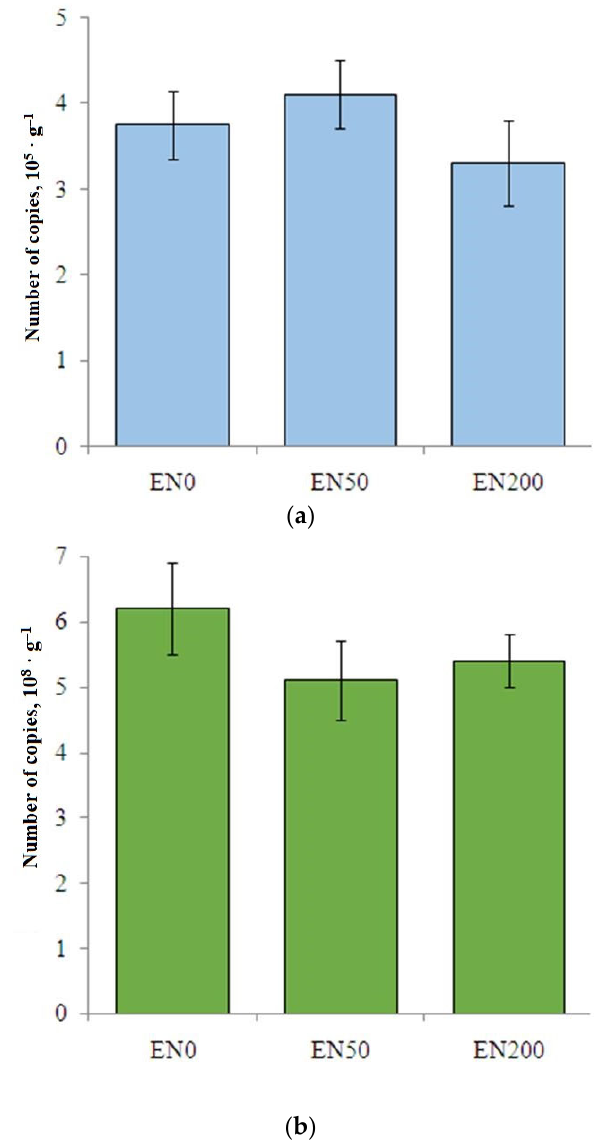
Figure 7. Number of nirS ( a ) and nirK ( b ) genes copies in earthworms’ gut.